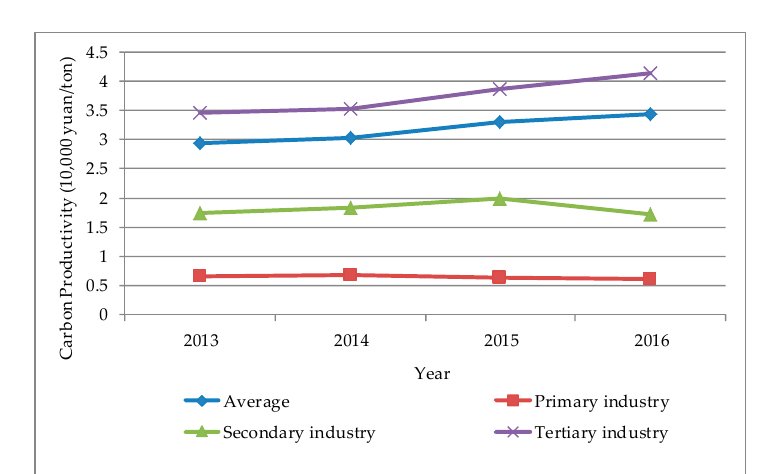
Figure 4. Carbon productivities of different industries in Beijing (2013–2016).